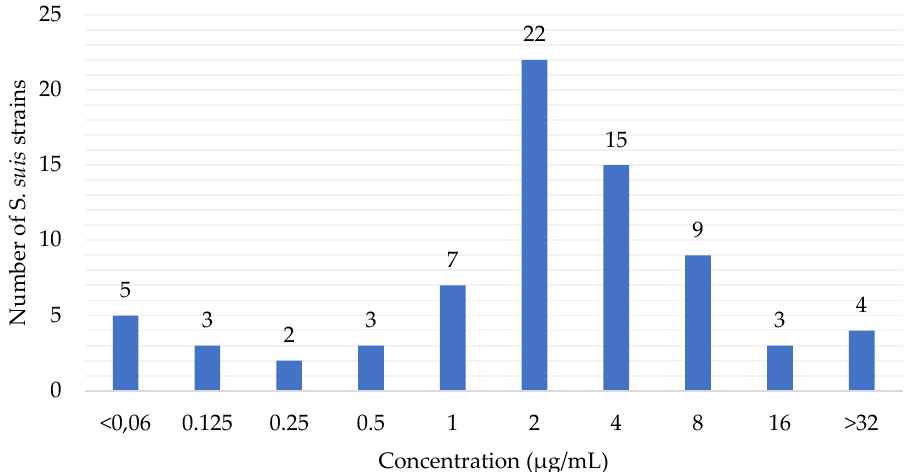
Figure 2. Minimum inhibitory concentration (MIC) distribution of florfenicol against S. suis in Hungary between 2018 and 2022 (n = 73).